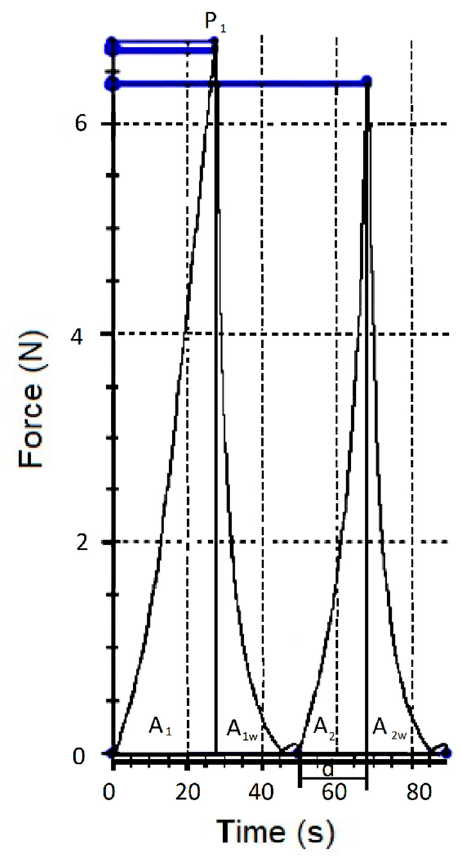
Figure 1. Force-time curves corresponding to the texture profile analysis. P1—force to obtain a deformation of 20% of the equatorial diameter of the berries. A1, A1w, A2, and A2w—areas underpinning specific portions of the force–time curve. d—springiness.